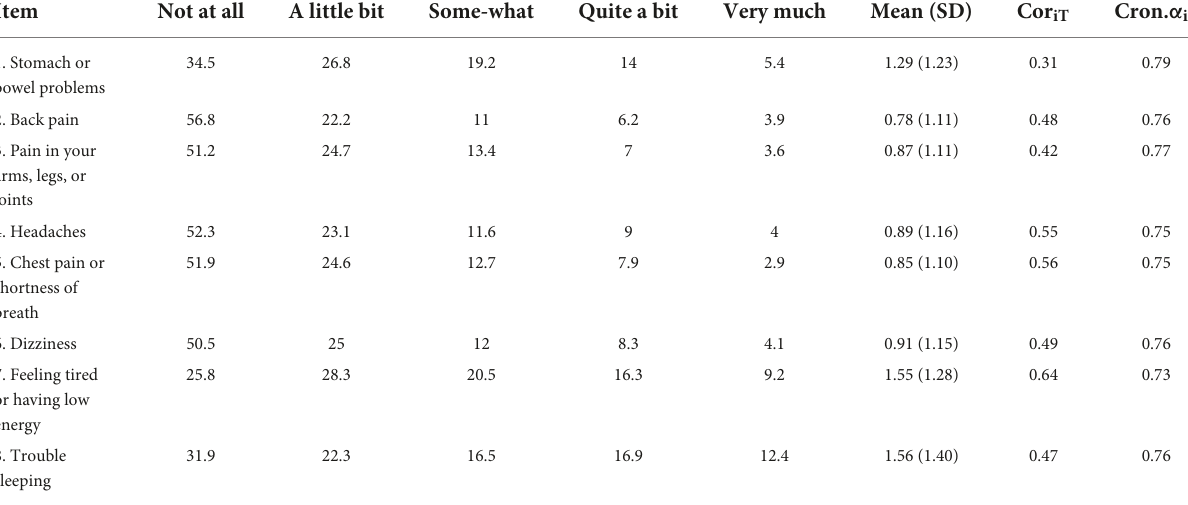
TABLE 2 Frequency distribution of responses (%), mean (SD), and item-total correlations for the items of the SSS-8. Item Not at all A little bit Some-what Quite a bit Very much Mean (SD) Cor iT Cron. α